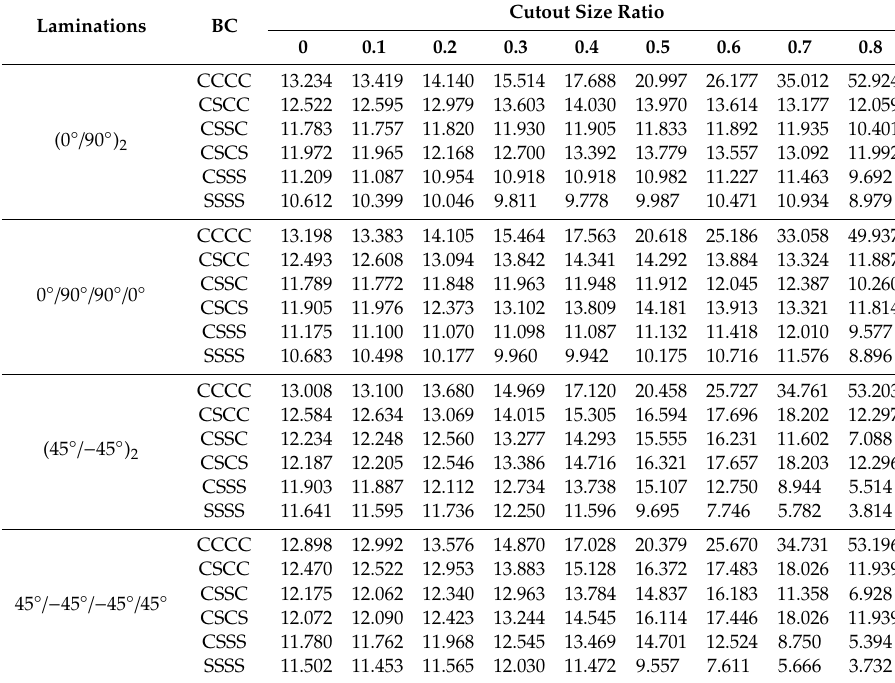
Table 10. Fundamental frequency parameters Ω of square plate for various cutout size ratio with di ff erent boundary